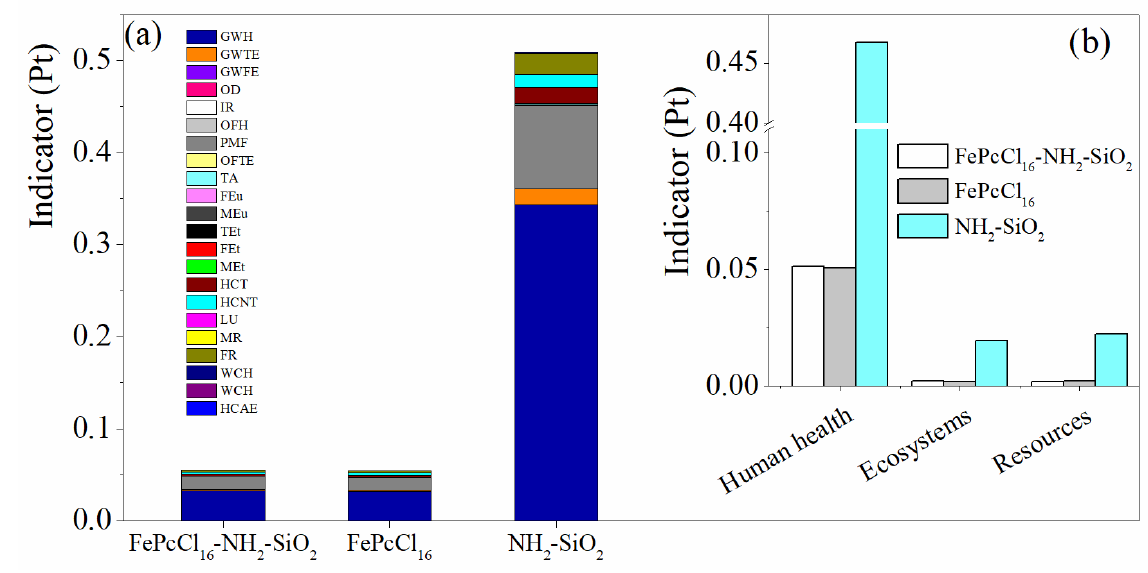
Figure 6. Comparison of the environmental impacts assessment by weighting indicators in the production of the catalyst FePcCl 16 -NH 2 -SiO 2 , support and active phase . ( a ) Impact categories by single score and ( b ) damage categories. Assessment method: ReCiPe 2016 Endpoint (H) V1.06/World (2010) H/A; Pt: points.